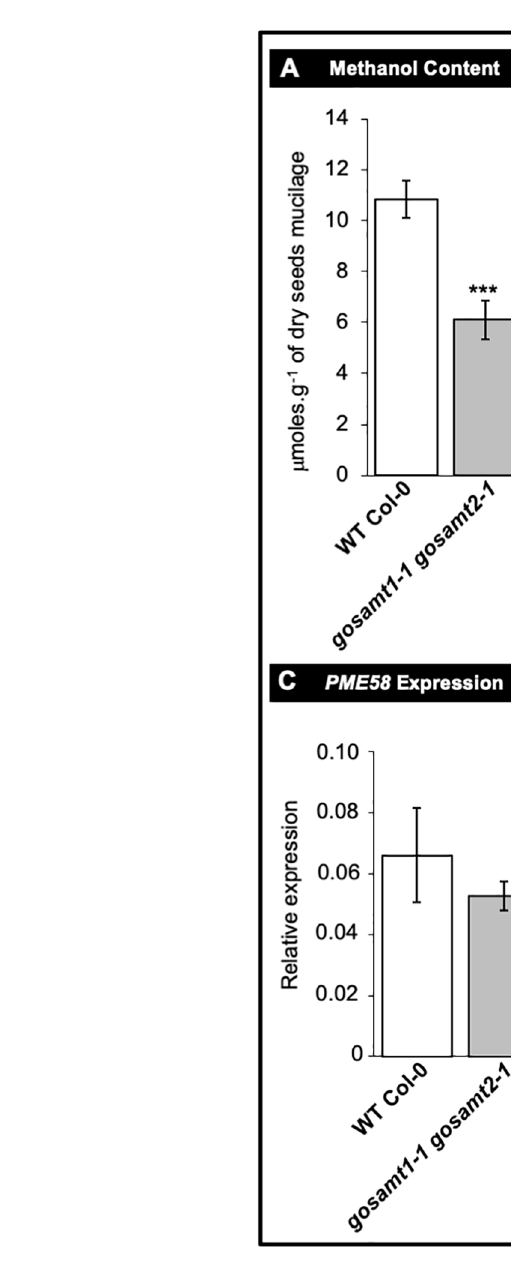
FIGURE 8 Pectin methyl-esterase (PME) metabolism remains unaffected in gosamt1-1gosamt2-1 double mutant mature seed. (A) Methanol content of soluble plus adherent mucilage layers determined by colorimetric assay after saponi fi cation. Mean values are represented with standard error of n = 15 from three biological replicates; statistical difference observed during Mann-Whitney analysis with *** p <0.001. (B) Global PME activity measured using total protein extract from nature dry seed. Mean PME activity in WT Col-0 normalized to 100%; data presented as mean values ±SD from three biological replicates ( n = 18); each circle represents WT Col-0 and gosamt1-1gosamt2-1 double mutant measurement value; no statistical difference observed during t -test analysis. (C, D) PME58 and PME16 expressions measured in mature dry seeds. qRT-PCR analysis used to determine PME58 and PMEI6 transcript levels in mature seeds. Steady state mRNA levels are represented as percentage of constitutive EF1a4 and seed reference (At4g12590) genes. Error bars represent SE values from three biological replicate ( n = 9); Mann-Whitney U test with the wild type with